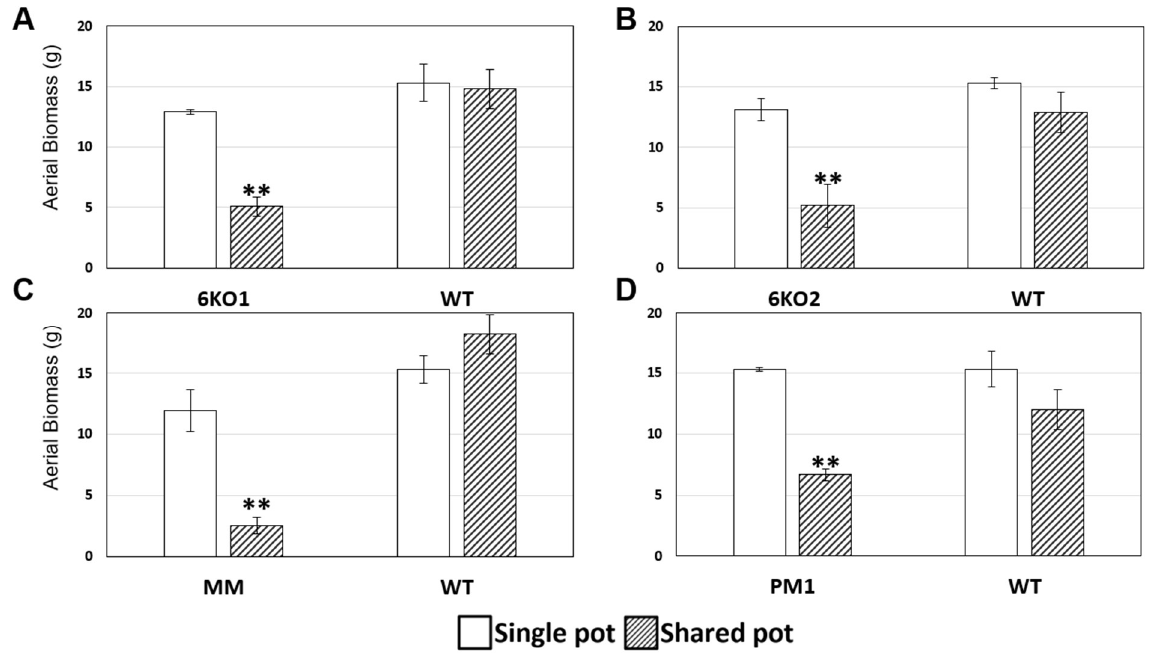
Figure 6. Growth of well-watered wildtype (WT) and mutant lines in single pots (white) and shared pots (diagonal pattern). The average dry aboveground biomass (g) for wildtype and ( A ). 6KO1 ( B ). 6KO2 ( C ) MM and ( D ). PM1 mutant plants. ** = p < 0.01; n ≥ 3.